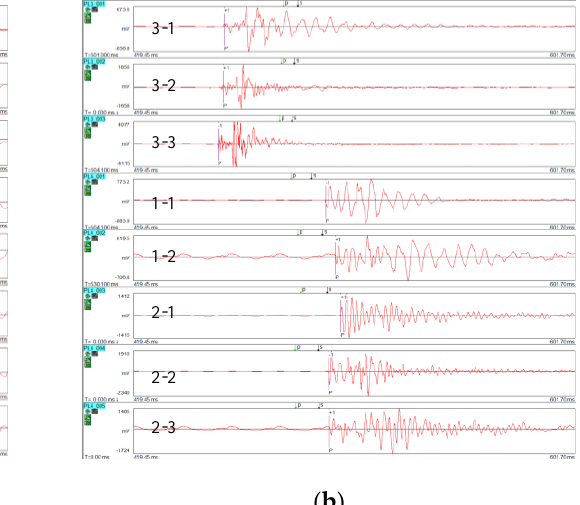
Figure 11. Twin-tube array for microseismic monitoring of the Micang Mountain tunnel with three monitoring sections. The red sphere represents the microseismic event.